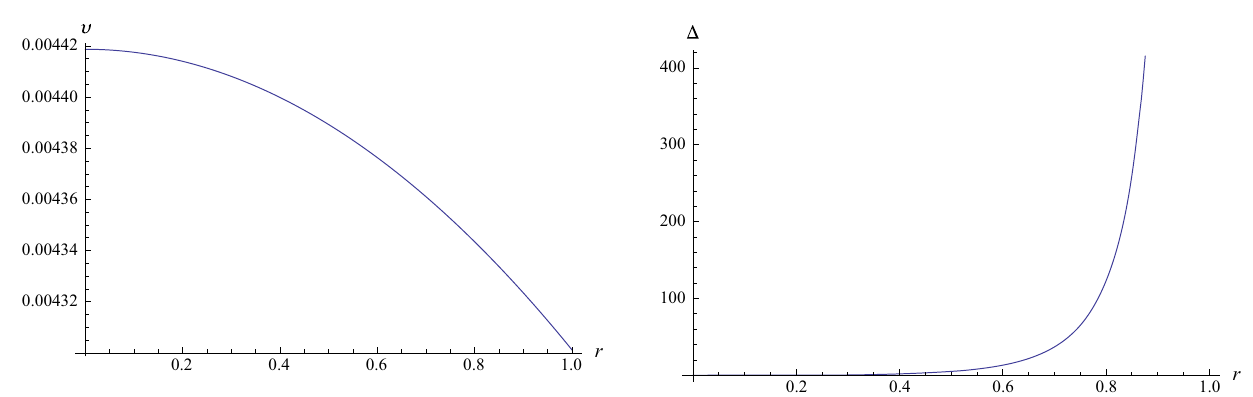
Fig. 5 Speed of sound v with n = 1 ,α = 0 . 025 and d = 0 . 0804